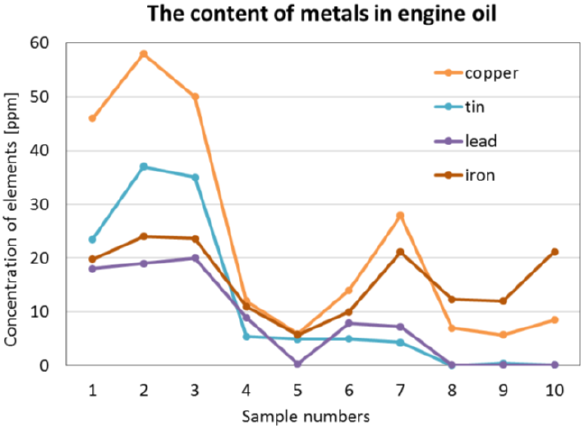
Fig. 9. Content of metals in engine oil samples